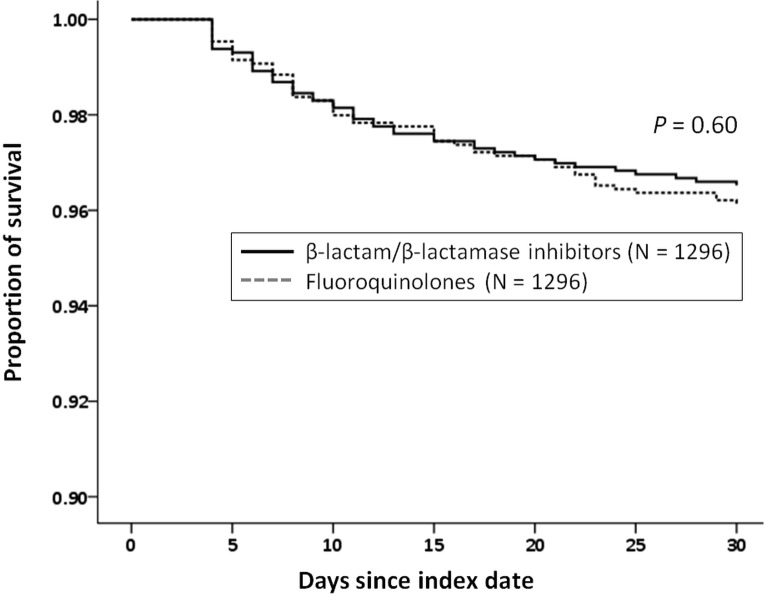
Kaplan-Meier estimates of time to pneumonia/empyema-related hospitalization/ emergency department (ED) visits based on receipt of fluoroquinolones and β-lactam/β-lactamase inhibitors in the matched cohorts.